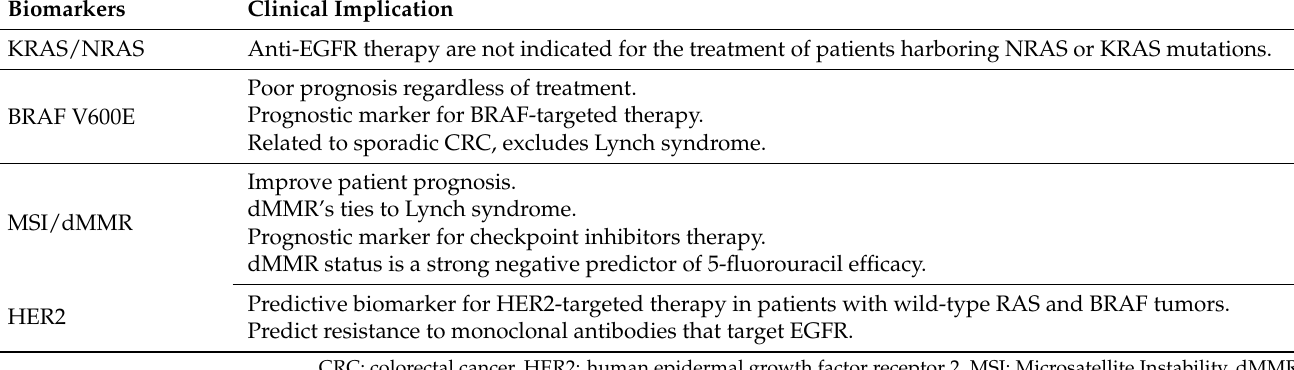
Table 1. NCCN recommended biomarkers for